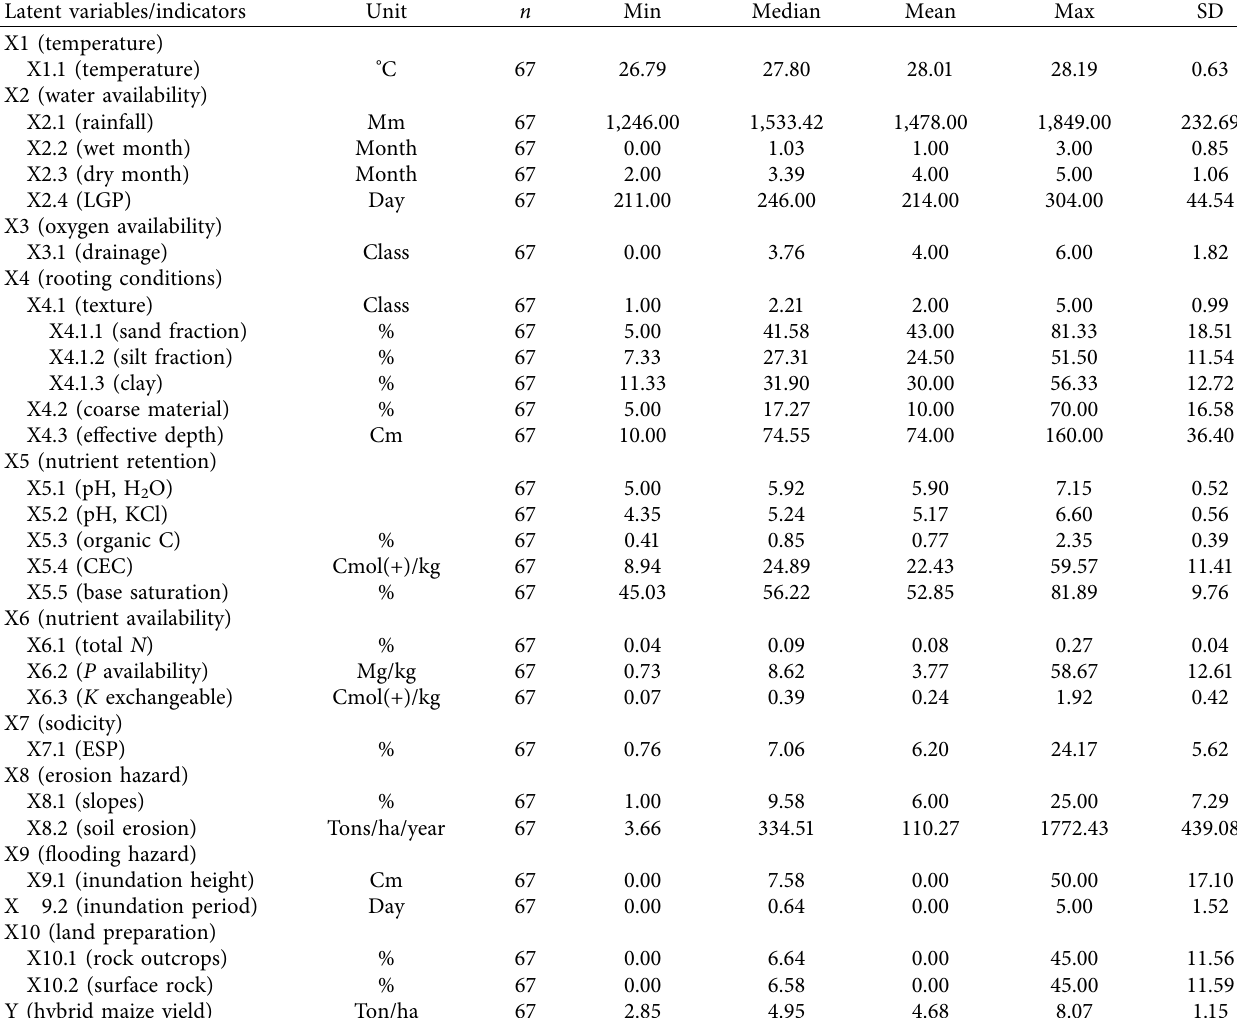
Table 2: Brief statistics of land quality and